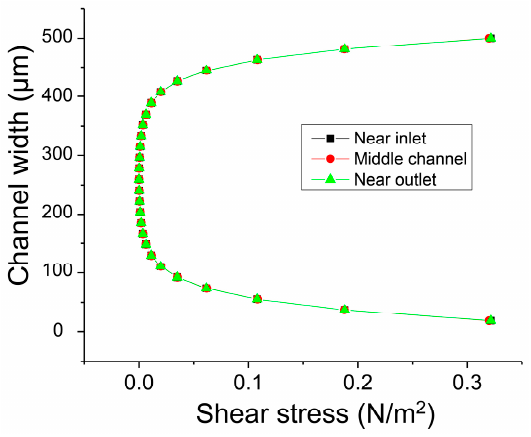
Figure 7. The distribution of shear stress along the microchannel.